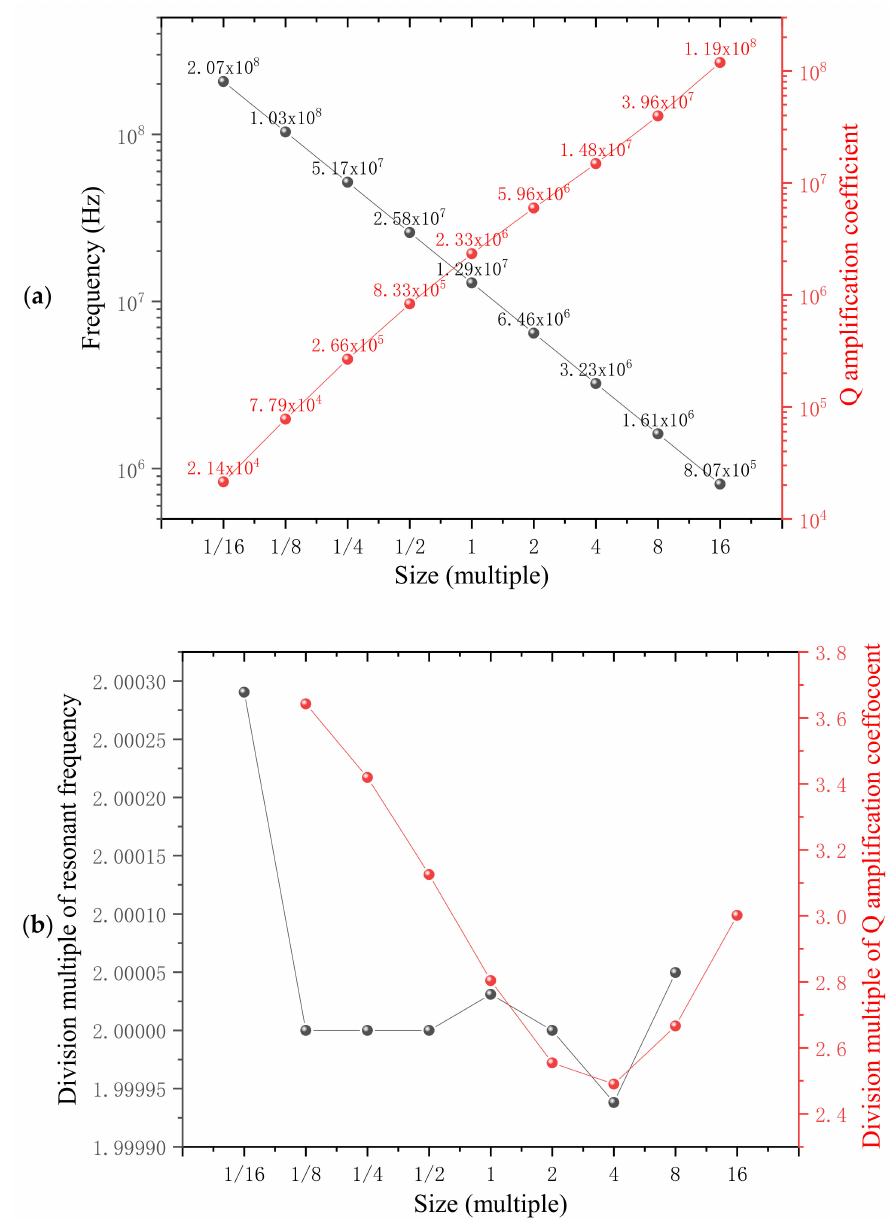
Figure 7. ( a ), The relationship between the overall size and Q amplification coefficient (red) along with the resonant frequency (black) in the form of logarithmic coordinates. ( b ) Division multiples between adjacent two resonance frequencies as well as Q amplification